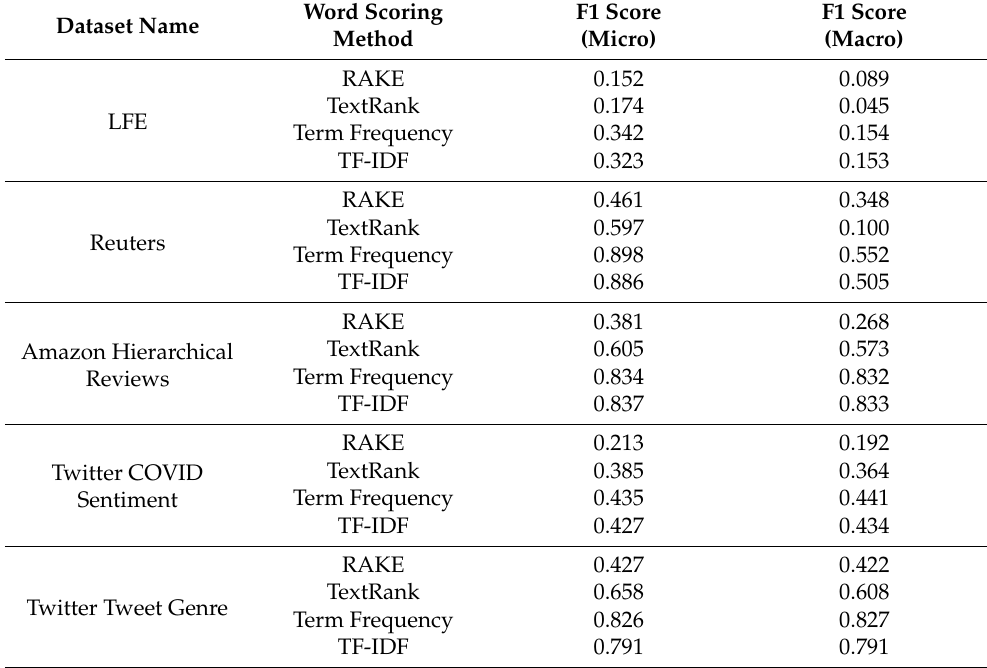
Table 4. Evaluates the effect of using different word scoring techniques on the accuracy of classifi- cation. The same processing pipeline is maintained aside from word scoring (stop words removal, words lemmatization, additional text cleaning, BoW, CNB).